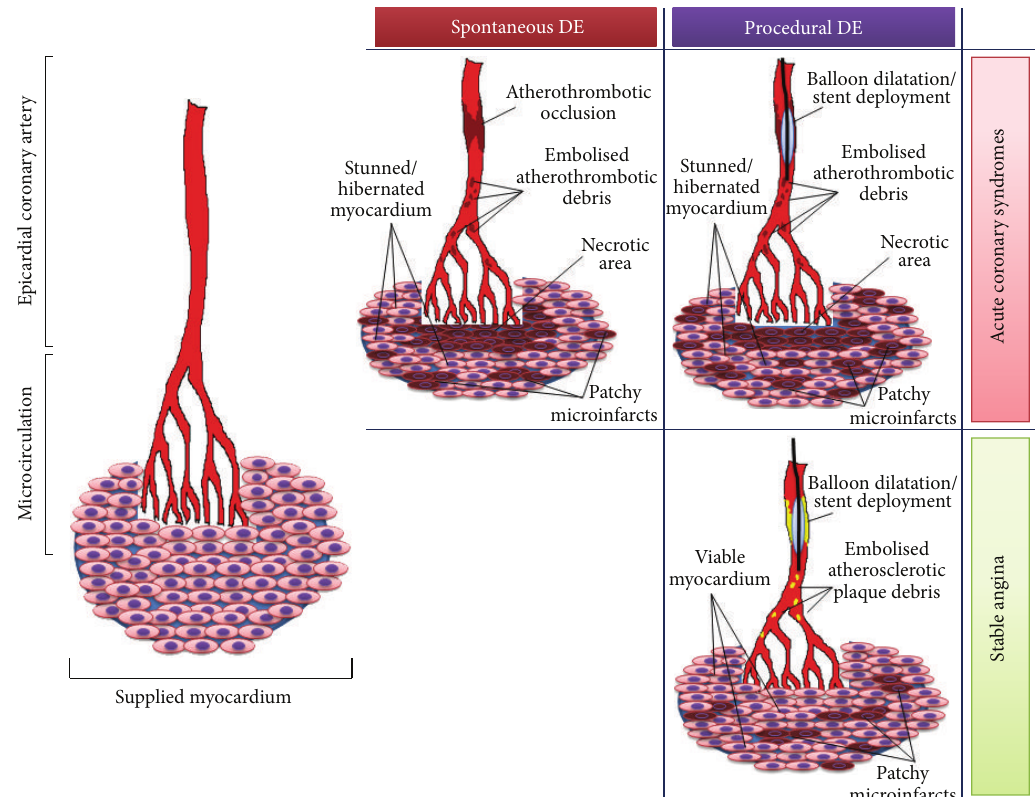
Figure 2: Mechanisms and consequences of “spontaneous” and “procedural” distal embolisation in stable coronary artery disease and in acute coronary syndrome. In spontaneous distal embolisation, occurring only in ACS patients, dislodgement of atherothrombotic debris contributes to enlargement of the area of myocardial injury and microvascular obstruction consequent to epicardial coronary occlusion. This damage is further increased by debris shower during revascularization procedure (procedural distal embolisation). In stable coronary artery disease only procedural distal embolisation occurs, causing patchy